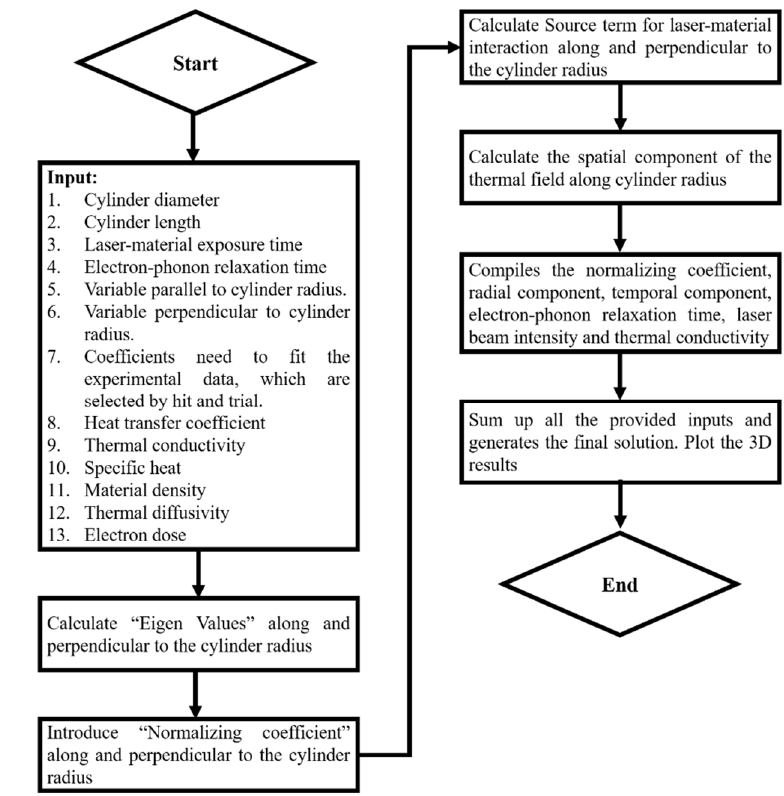
Figure 3. Flow chart to conduct simulation using non-Fourier heat equation.